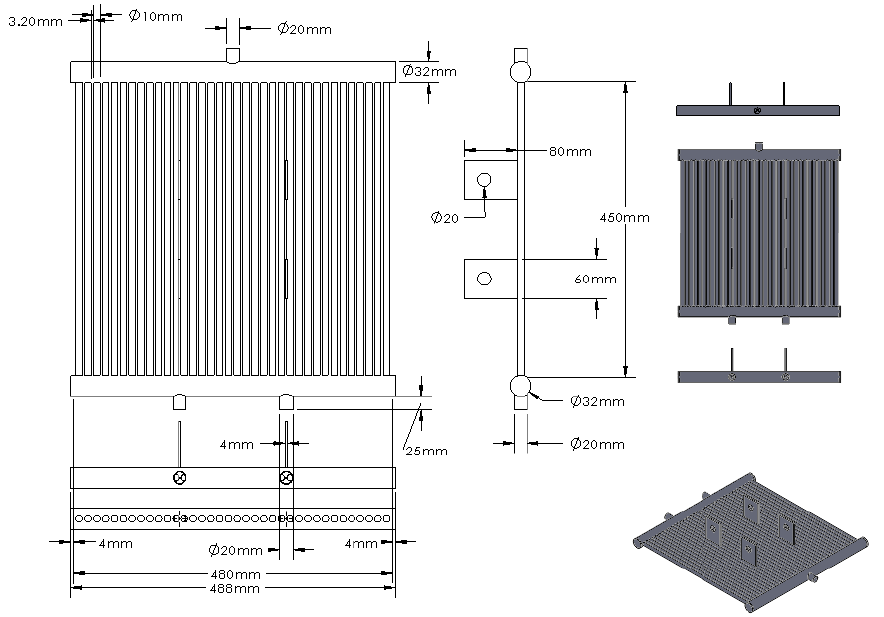
Figure 2. Detailed schematic of the Receiver panel.